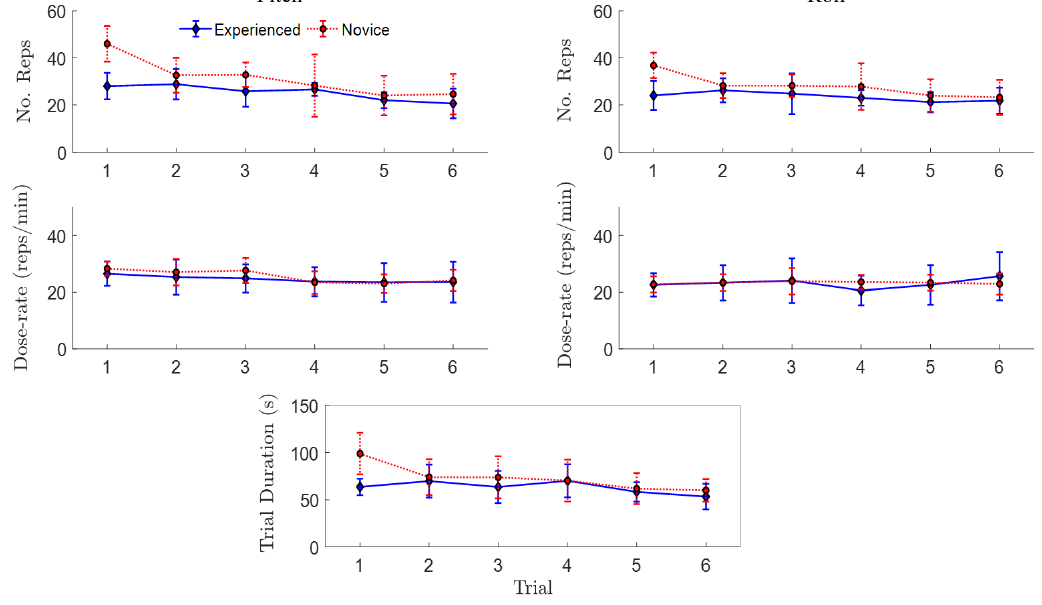
Figure 7. Mean ± SD quantity of movement IMU-based metrics across six repeated trials including pitch and roll number of repetitions (No. Reps), dose-rate ( reps / min ), and trial duration (s), separated by video-game experience (experienced,